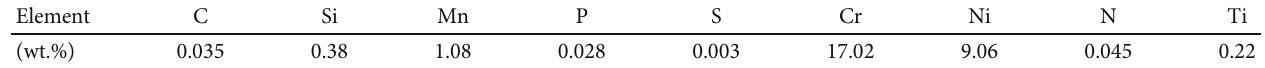
Table 1: Chemical composition of 321 austenitic stainless